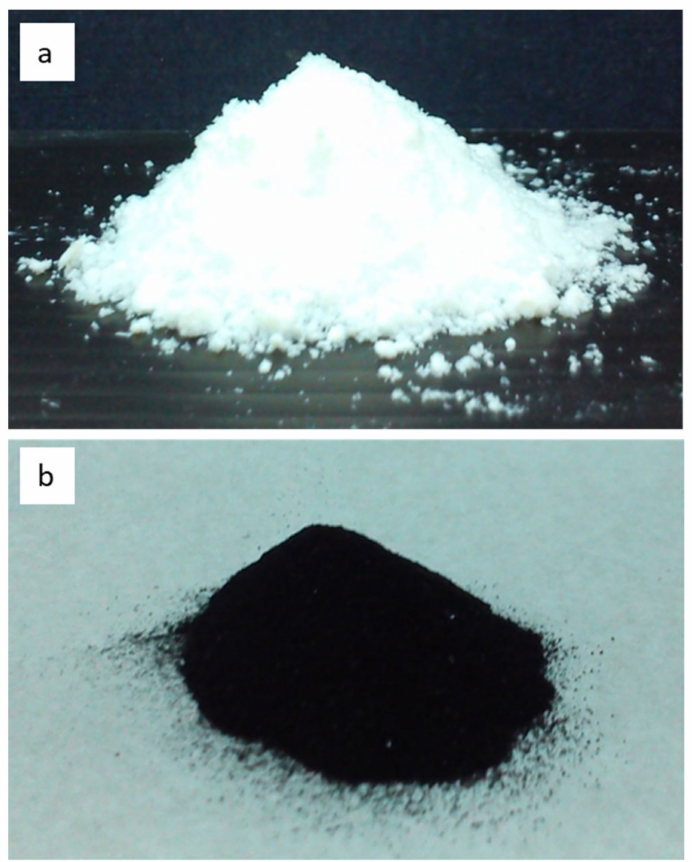
Figure 2. Photographs of ( a ) γ -Al 2 O 3 nanoparticles and ( b ) conductive PANDB/ γ -Al 2 O 3 core–shell nanocomposite synthesized via in situ polymerization (weight ratio of AN/ γ -Al 2 O 3 =